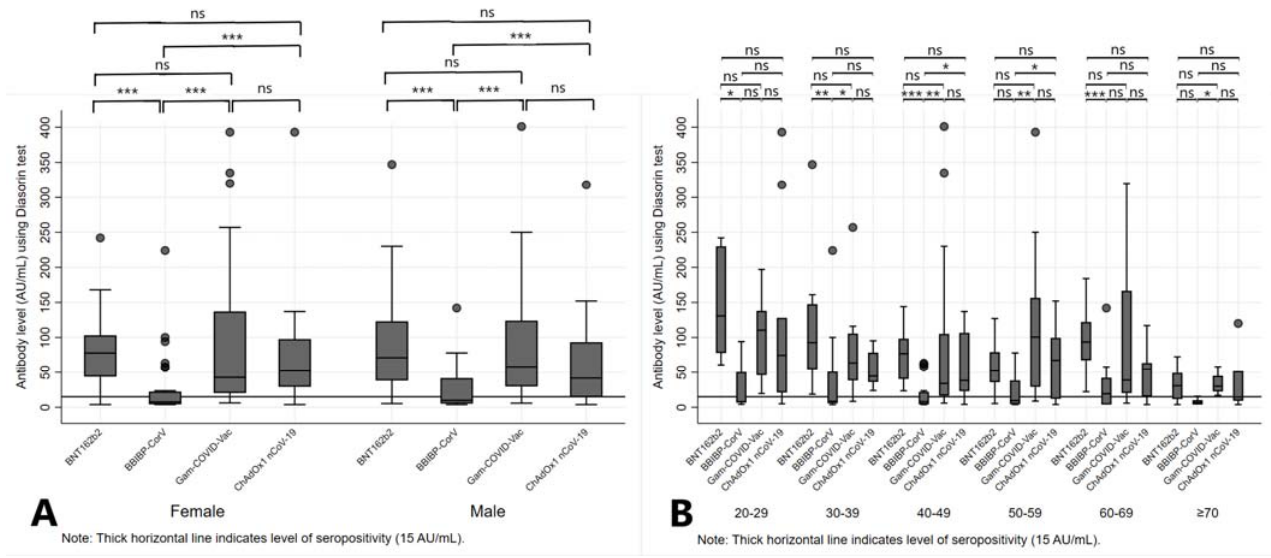
Figure 4. Antibody levels at 6 months after the administration of BNT162b2, BBIBP ‐ CorV, Gam ‐ COVID ‐ Vac and ChAdOx1 nCoV ‐ 19 vaccines, stratified by sex ( A ) and age groups ( B ) of participants. Legend: *** p < 0.001, ** p < 0.01, * p < 0.05, ns = not significant.